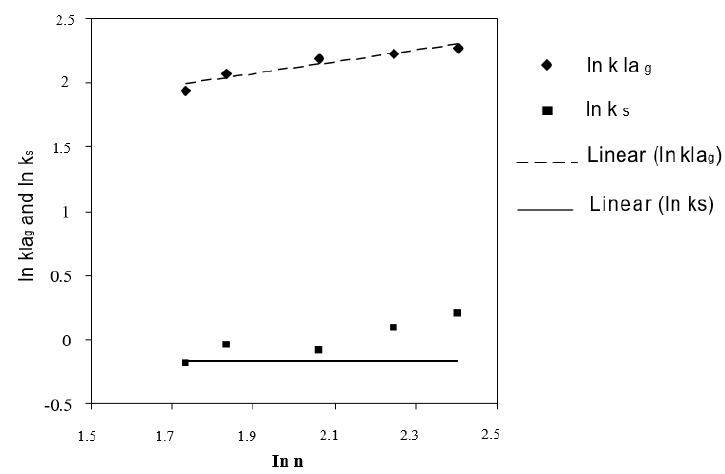
Figure 3. The relationship between ln k l a g and ln k s with ln N